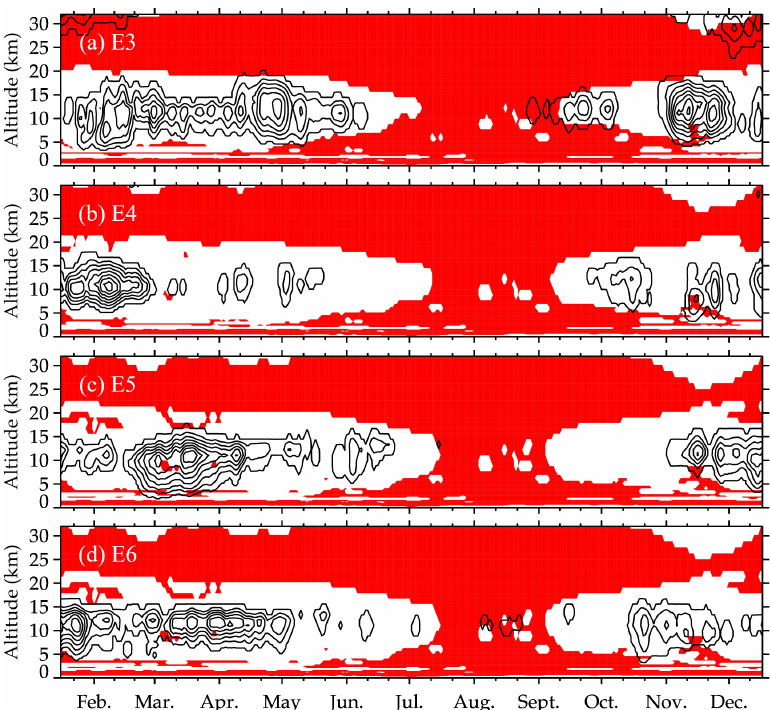
Figure 5. Time–altitude sections of the refractive index squared and zonal wind amplitudes of: ( a ) E3; ( b ) E4; ( c ) E5; ( d ) E6 10DWs at 32 ◦ N in 2020. Regions with a negative refractive index squared are shaded in red, and the black contours denote the zonal wind amplitudes of the 10DWs. Contours are from 2 ms − 1 at an interval of 0.5 ms − 1 .